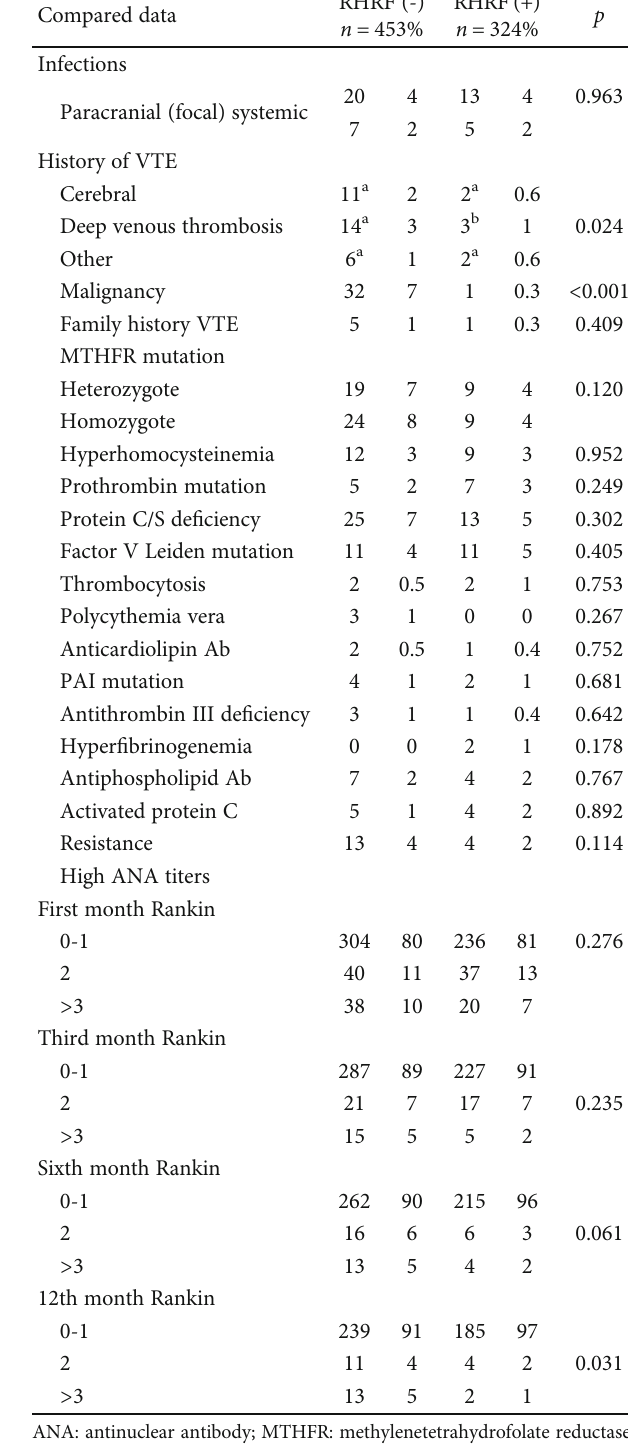
Table 2: Comparison of etiological factors and outcome according to the RHRF (-) group or the RHRF (+)